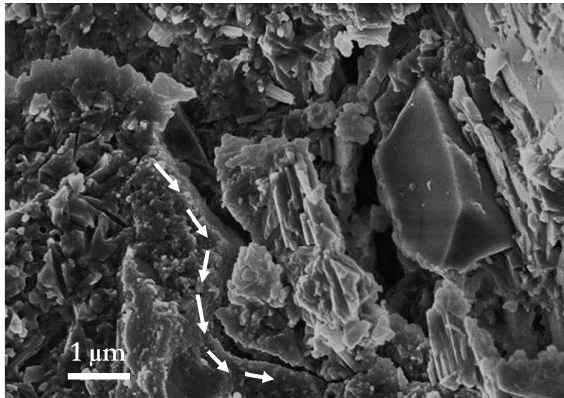
Figure 11: Crack passing through a large inert particle and crack branching.